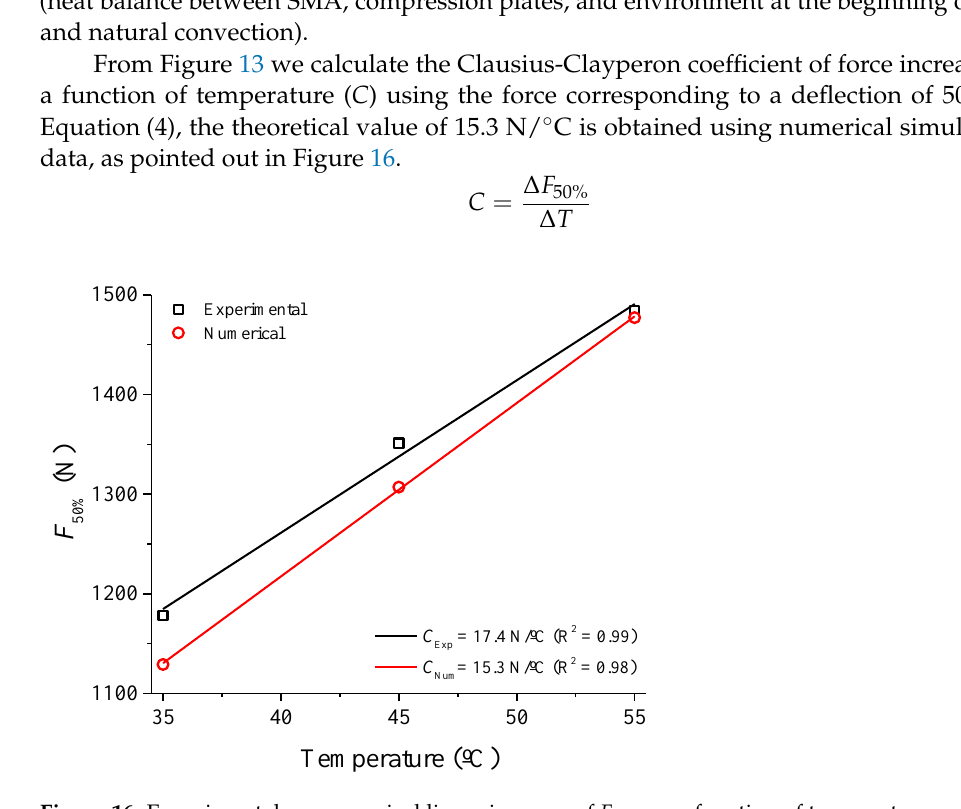
T − T mean from Figure 10, it is possible to make a simplification to estimate the force increase at 50% deflection, Δ F 50% , using Equation (4) ( Δ F 50% = C ( T − T mean )). This estimated increase